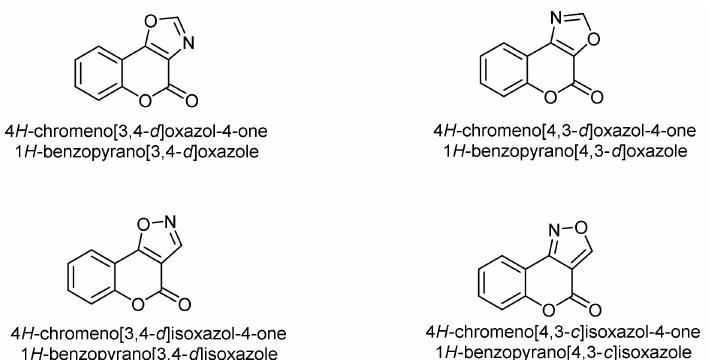
Figure 4. The common four isomers of fused oxazole and isoxazole ring to the α -pyrone moiety of the